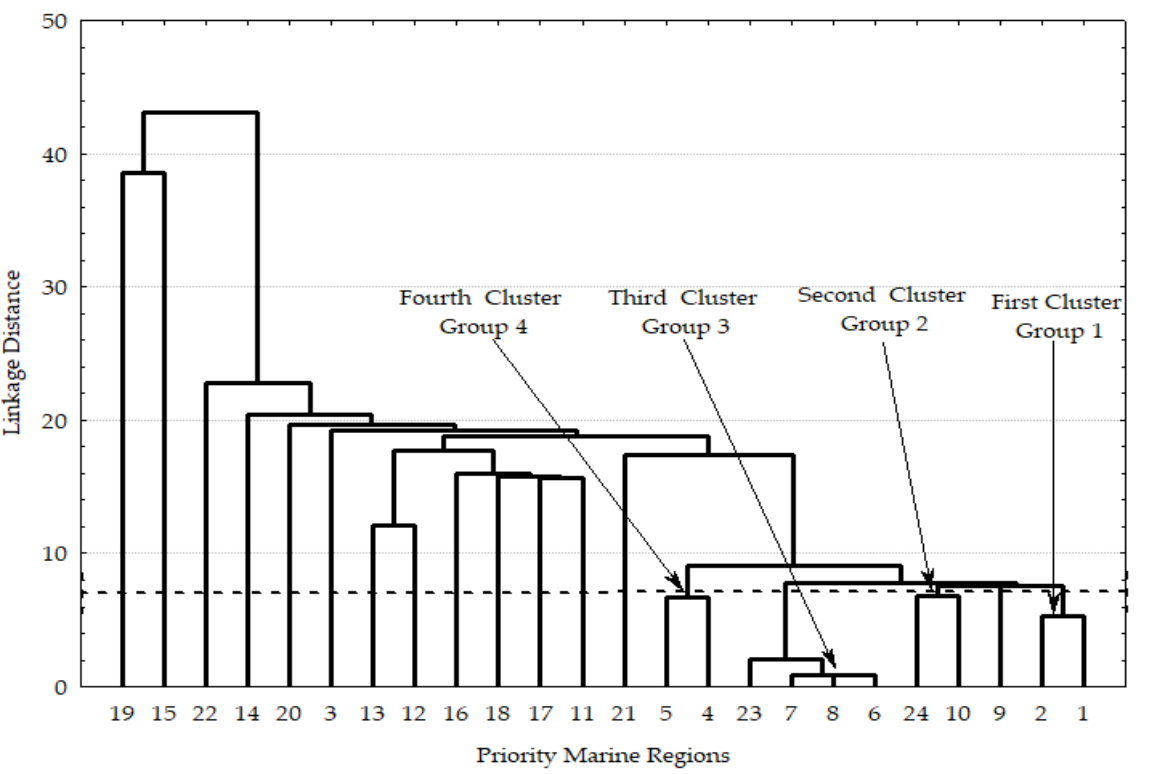
Figure 3. Cluster analysis of the regions using Priority Marine Regions (PMR) of the northwest of Mexico based on monthly Chlorophyll a (Chl a ) data. Linkage Distance (dotted line).